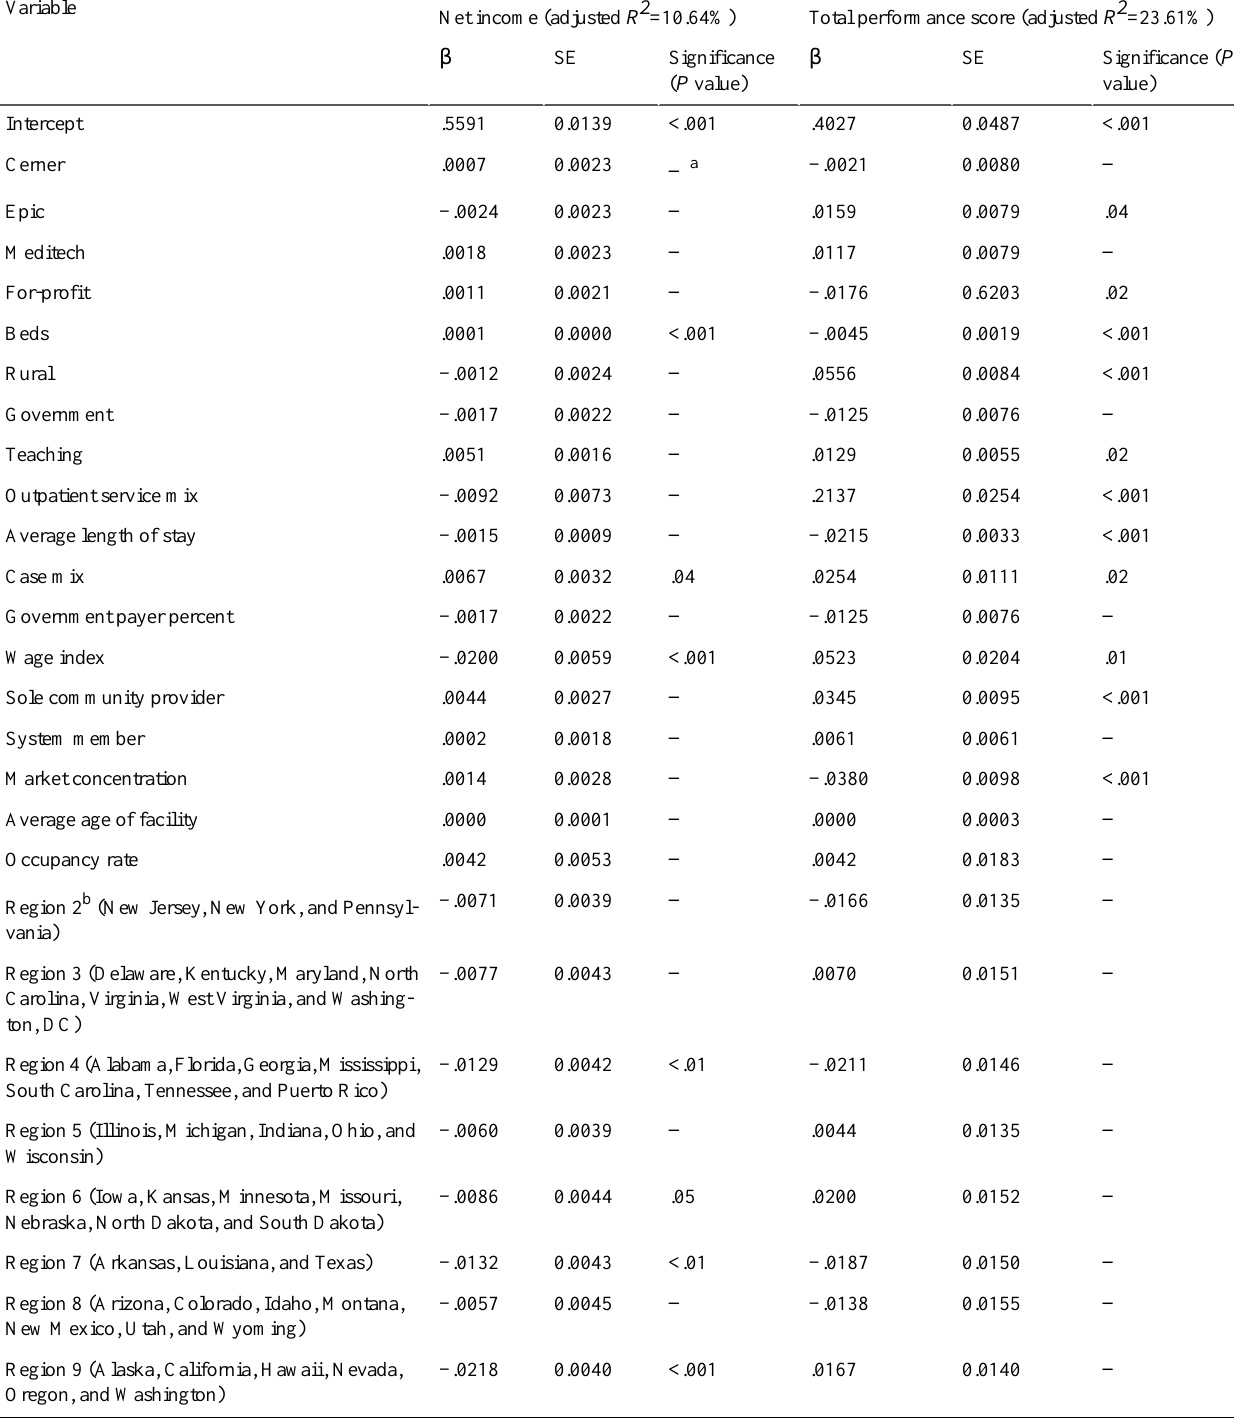
Table 3. Analysis results for net income and total performance